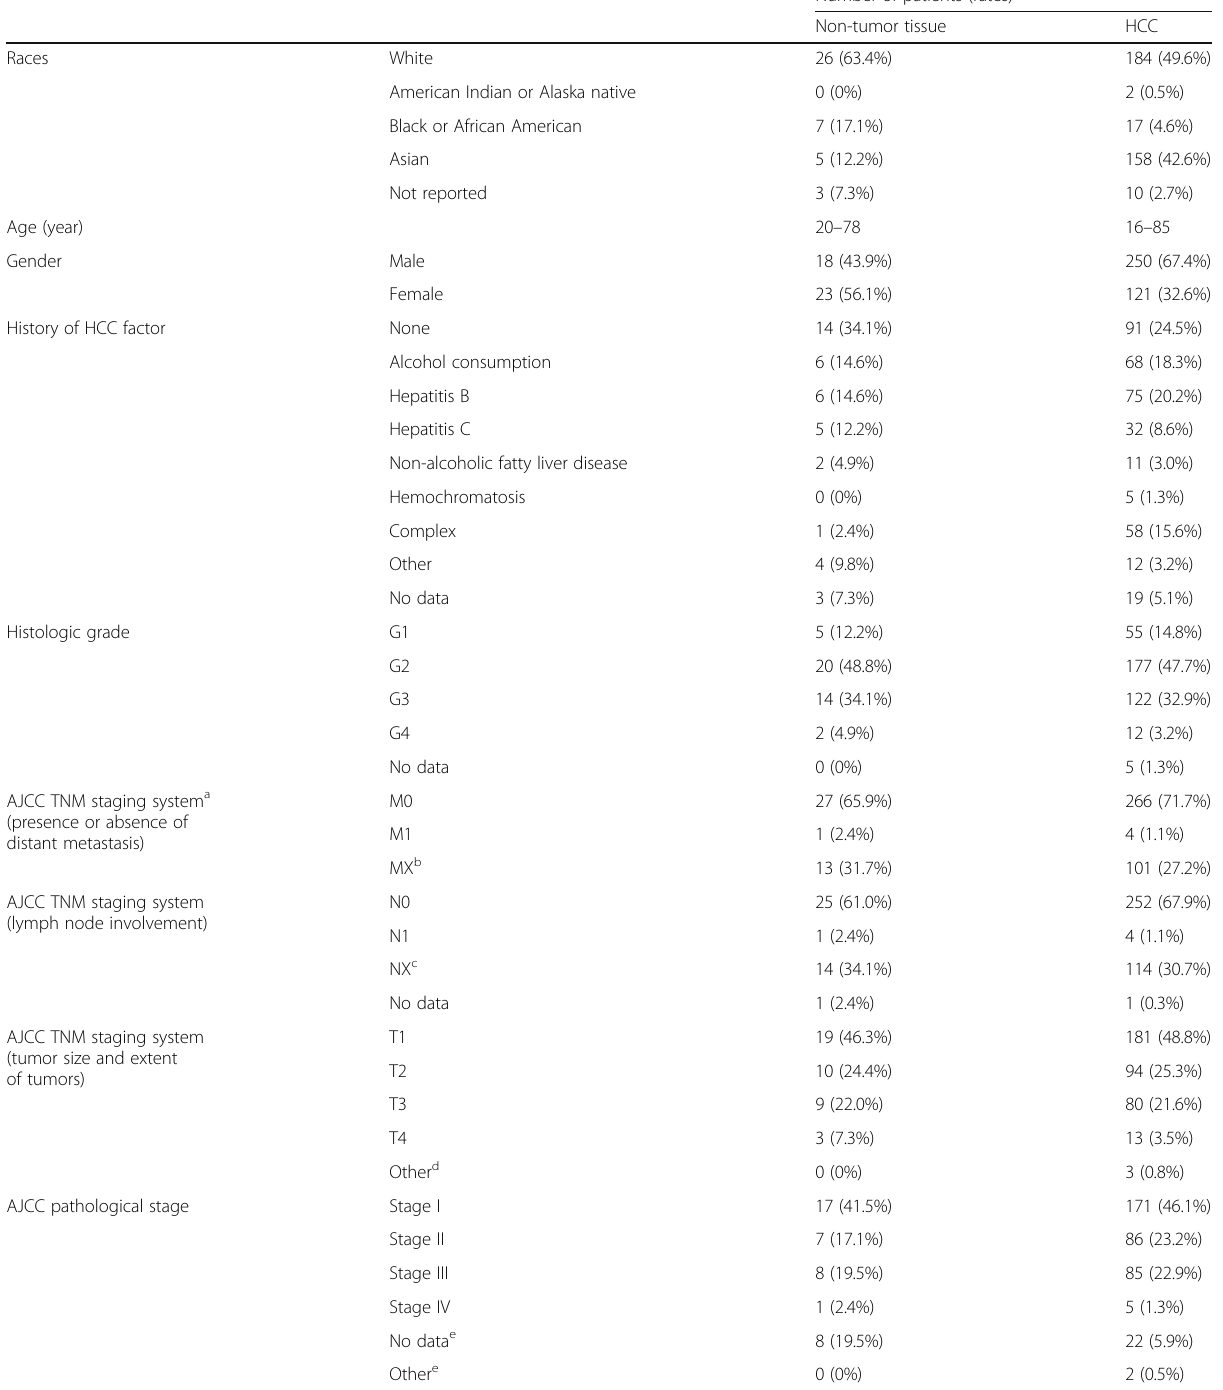
Table 1 Clinical features of